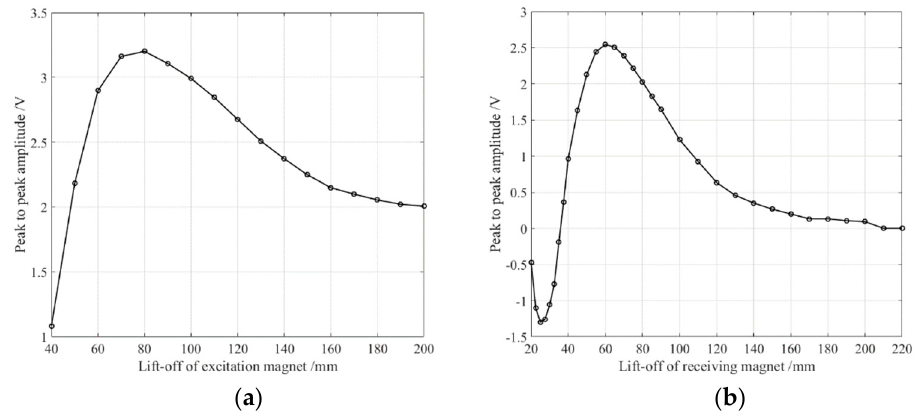
Figure 11. The peak to peak amplitude of the S0 Lamb wave versus the lift-off the excitation and receiving magnets. ( a ) shows the S0 wave’s peak to peak value varies with the excitation magnet’s lift-off. ( b ) shows the S0 wave’s peak to peak value varies with the lift-off of the receiving magnet.